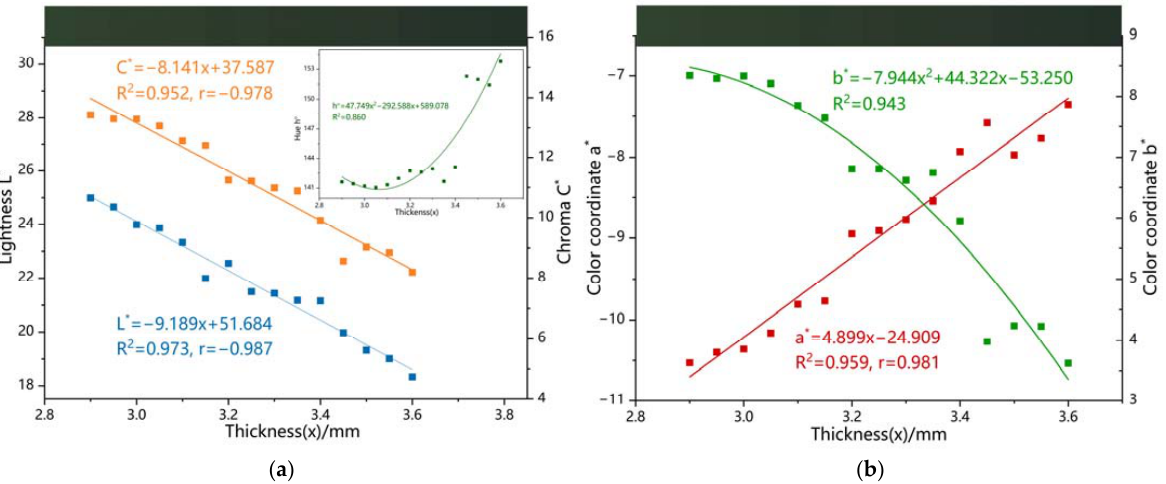
Figure 3. ( a ) Relationship between the thickness with the lightness L*, chroma C* and hue angle h°; ( b ) relationship between the thickness with color coordinates a* and b*. The correlation between thickness and lightness L* (R 2 = 0.973, r = － 0.987) was greater than that between thickness and chroma C* (R 2 = 0.952, r = － 0.978) and hue angle h° (R 2 = 0.860). Therefore, thickness has the greatest influence on lightness L*, the second highest on chroma C*, and the least influence on hue angle h°.